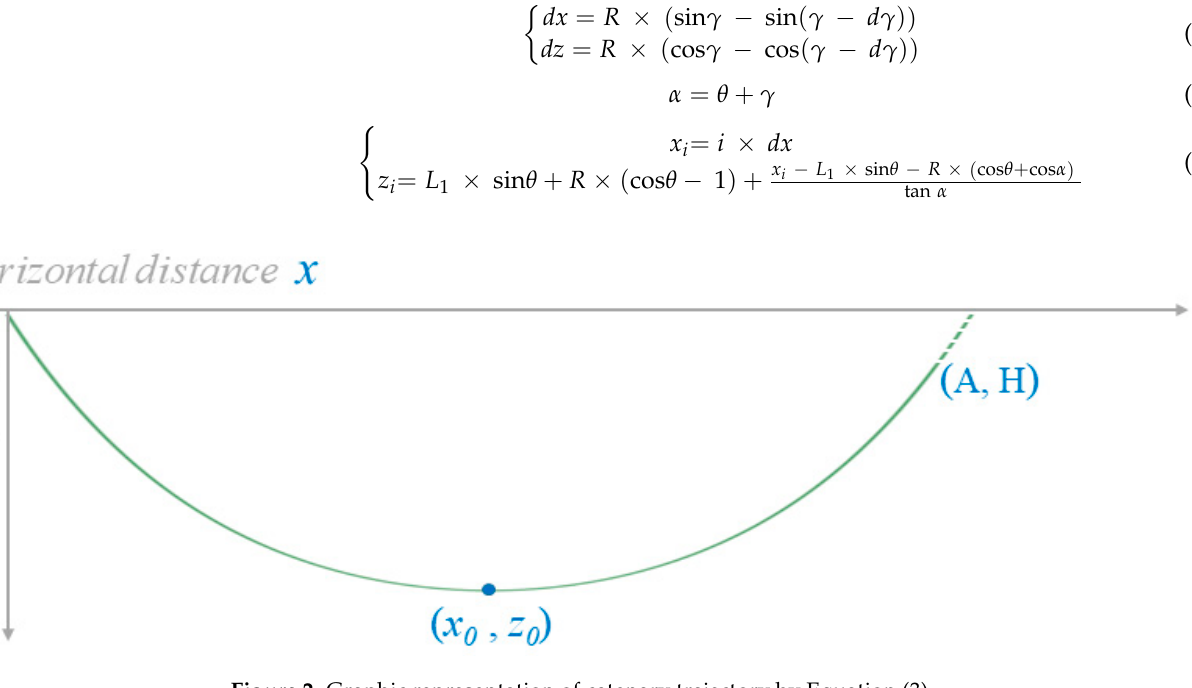
Figure 2. Graphic representation of catenary trajectory by Equation (3).